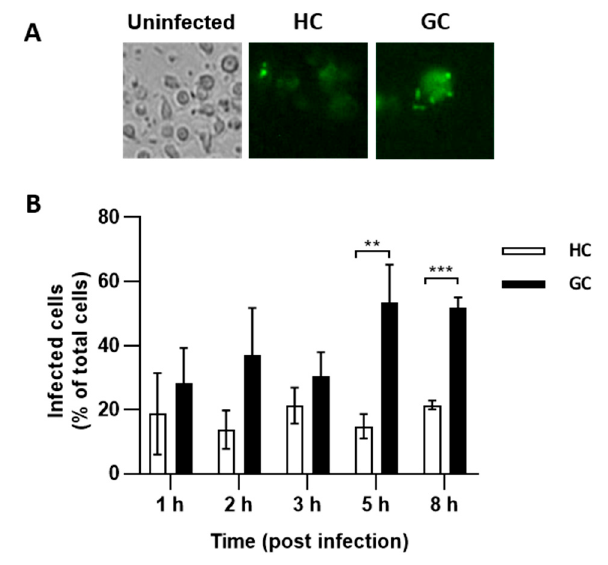
Figure 4. Killing of AIEC by monocyte derived macrophages (MDMs) from GC and HC. ( A ) Fluorescent microscopy images of GC and HC MDMs; uninfected and infected with a green fluorescent protein (GFP)-labelled AIEC strain CUKD2 at 5 h post-infection. ( B ) Number of infected MDMs as the percentage of total cells at various time points. ** p < 0.01, *** p < 0.001.